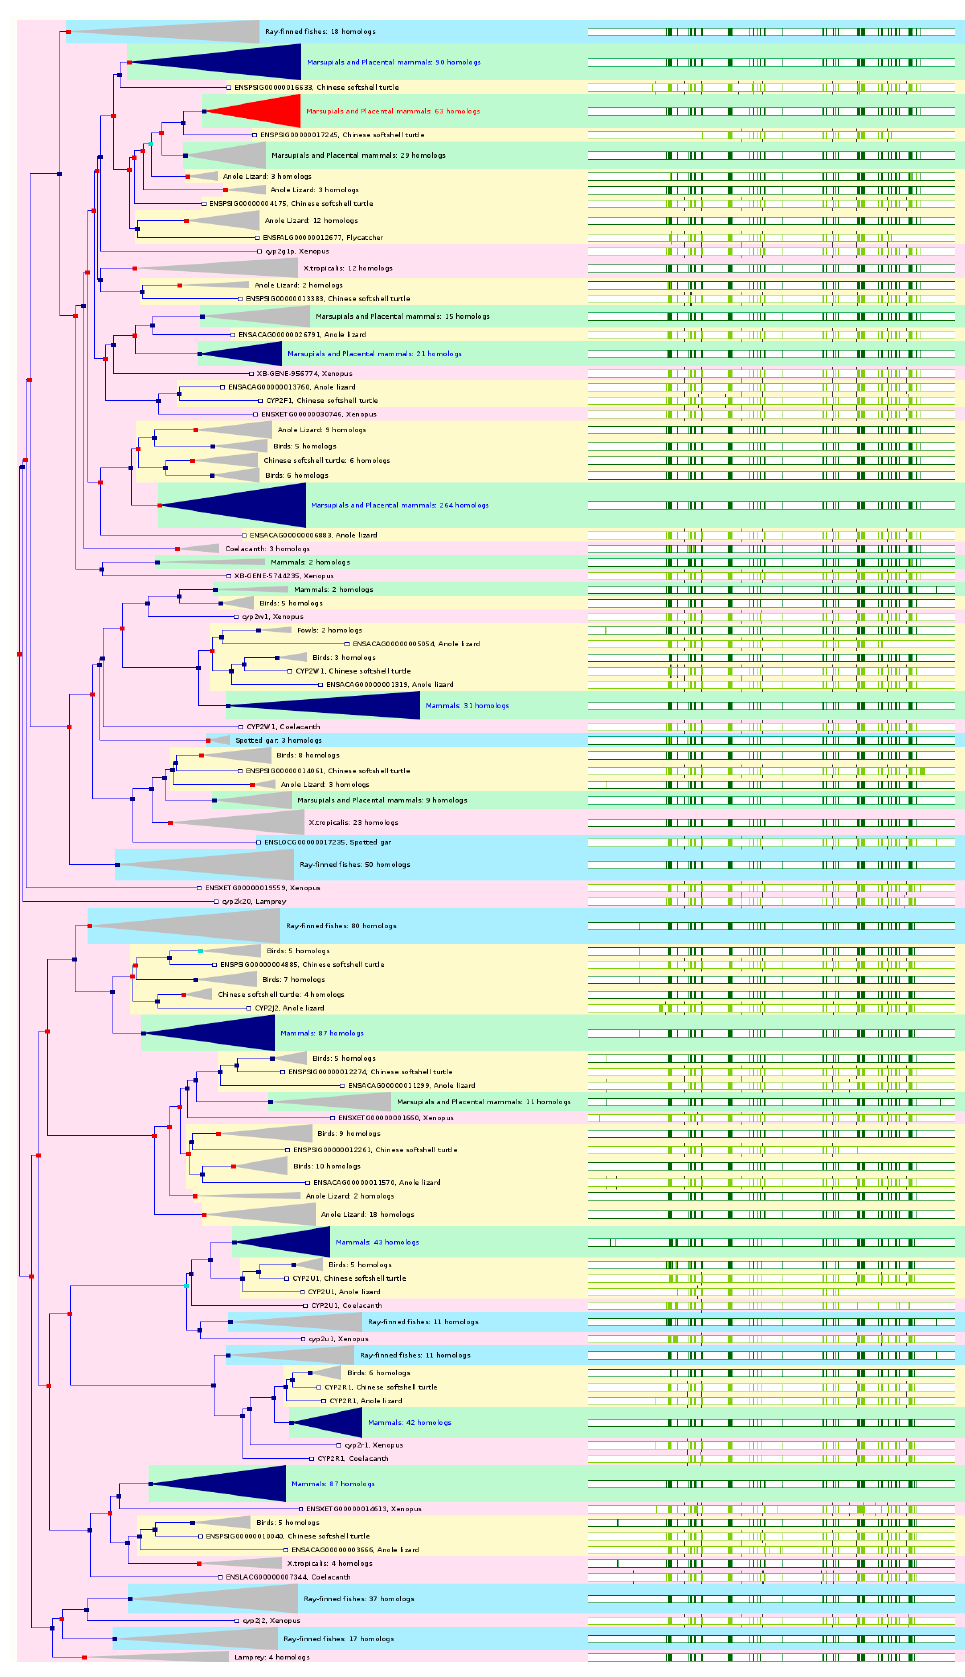
Figure 3. Cont. Figure 3.